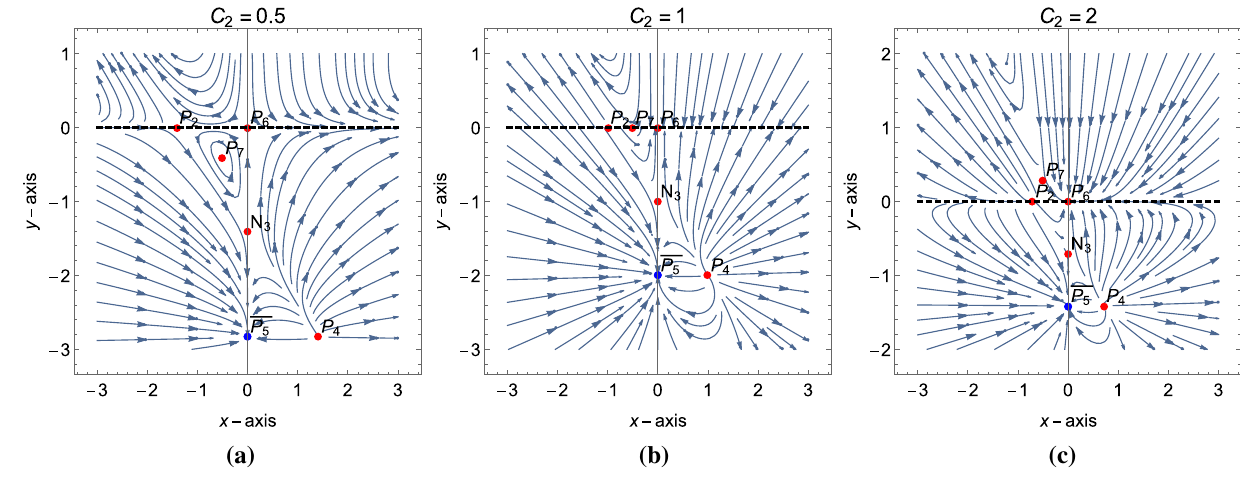
Fig. 4 Some orbits of system (60) for different choices of the parameter C 2